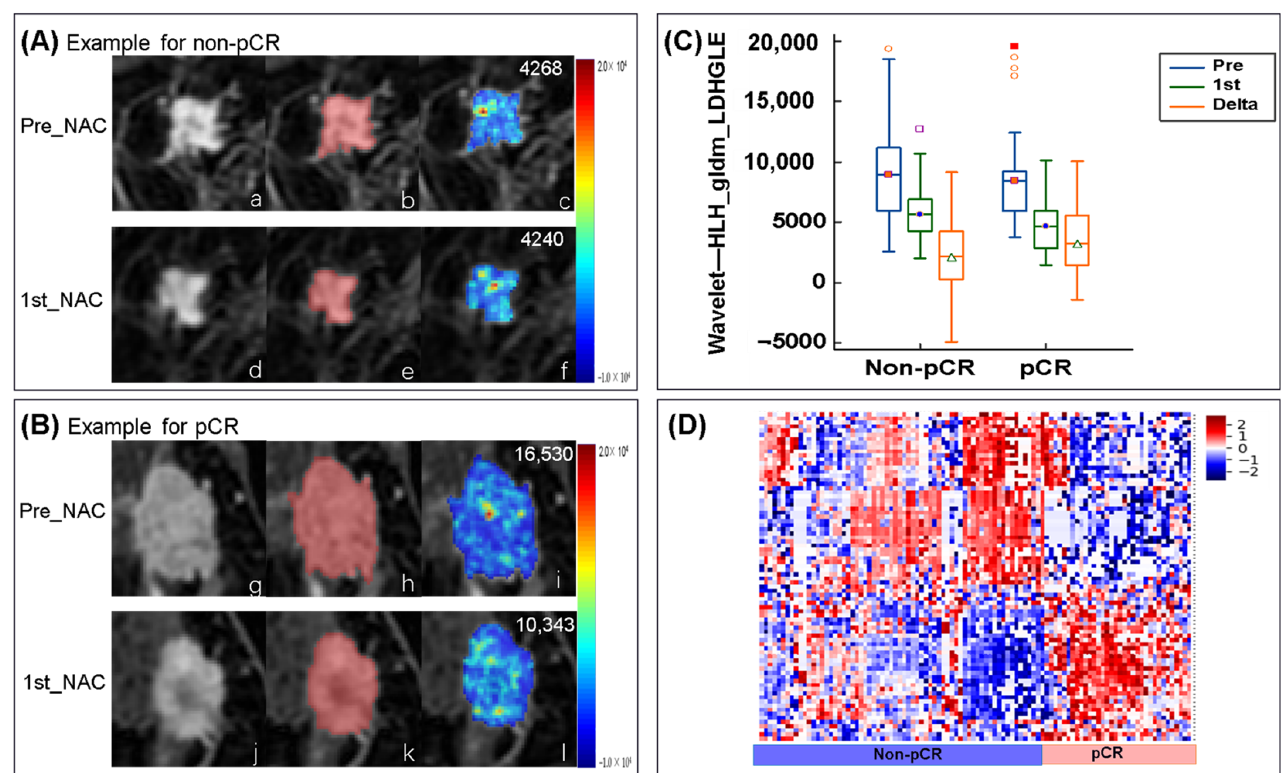
Figure 7. Examples feature of wavelet—HHL_ gldm_ Large Dependence High Gray Level Emphasis (LDHGLE) in non-pCR and pCR. ( A ) Images from a non-pCR breast cancer patient (aged 57 years old with invasive ductal carcinoma of the triple negative subtype. The first line is: ( a ) the image of pre-NAC, ( b ) ROI, and ( c ) a LDHGLE map of tumor ROI (mean LDHGLE value = 4268). The second line is: ( d ) the image of the first cycle of NAC(1st-NAC), ( e ) ROI, and ( f ) a LDHGLE map of tumor ROI (mean LDHGLE value = 4240). ( B ) Images from a pCR breast cancer patient (aged 51 years old